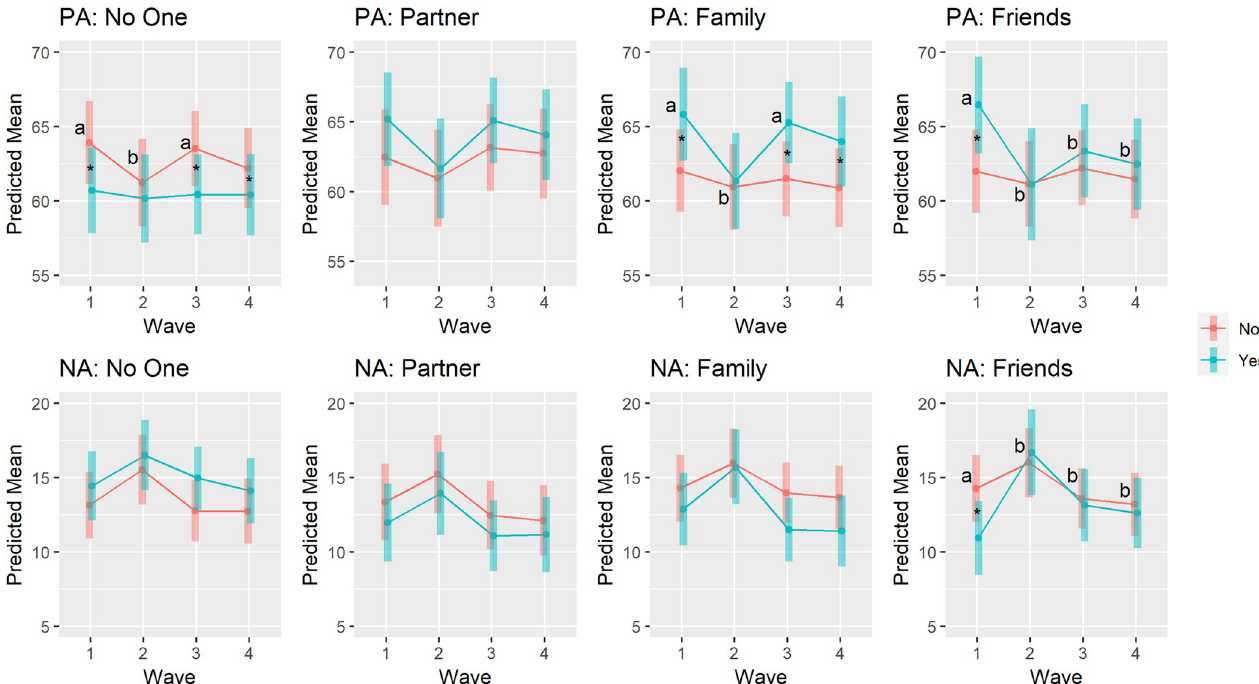
Fig 3. PA and NA predicted by momentary social interactions across waves. Note . For models with a significant “momentary social interaction × wave” interaction, � indicates that the difference in affect between with and without social interaction was significant at a specific wave and different letters indicate that the differences in affect between with and without social interaction in those waves were significantly different from each